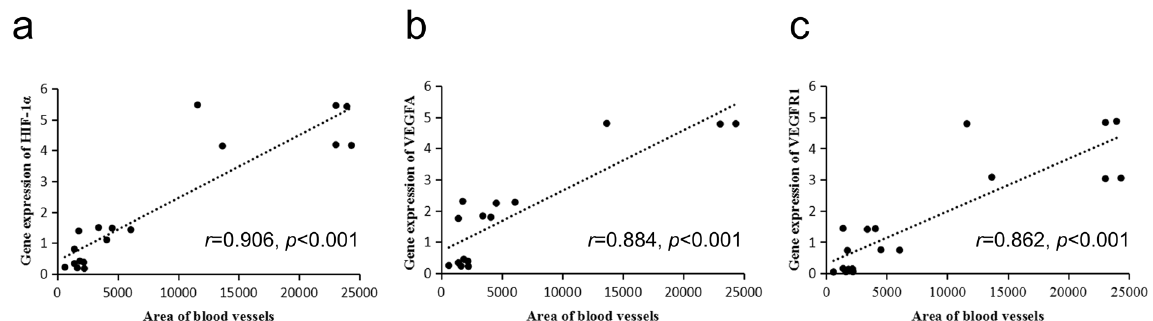
Figure 9. Evaluation of the correlation between the blood vessel area and gene expression. A positive correlation in HIF-1 α ( a ), VEGFA ( b ) and VEGFR1( c ) were found with Pearson’s test between the average blood vessel area (n = 6) and average gene expression level in the tibia (n = 3) during the